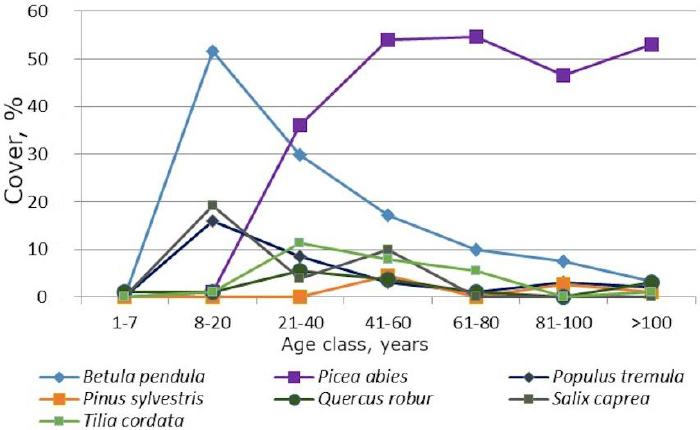
Figure 4. Average cover of canopy species (A1) in various age classes.